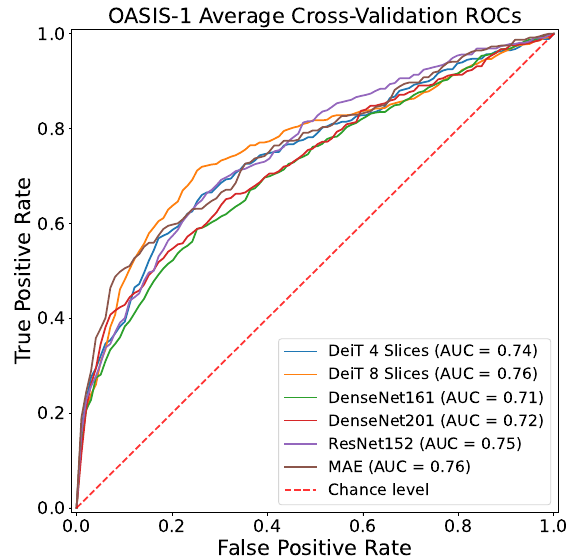
Figure 4. Cross-Validation ROCs related to OASIS-1